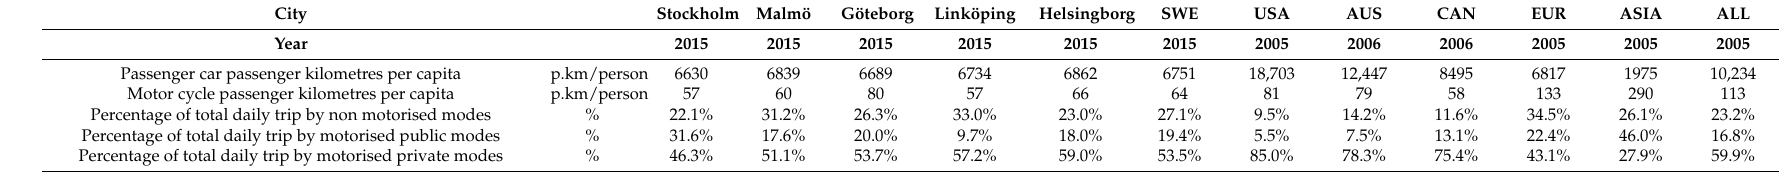
Table 7. Car and motorcycle use and modal split in Swedish and international